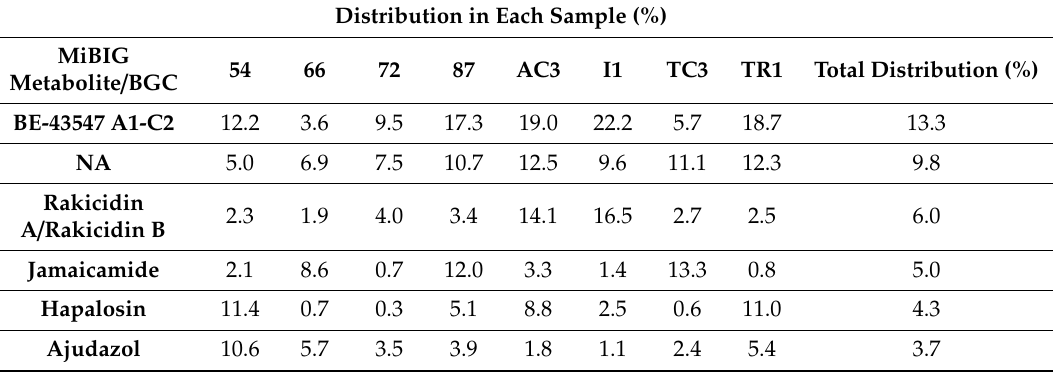
Table 2. Distribution of the five most abundant MiBIG metabolites assigned to the KS domain sequences. The distribution (in relative abundance) of each metabolite by sample as well as the total distribution of the metabolite across all the samples is